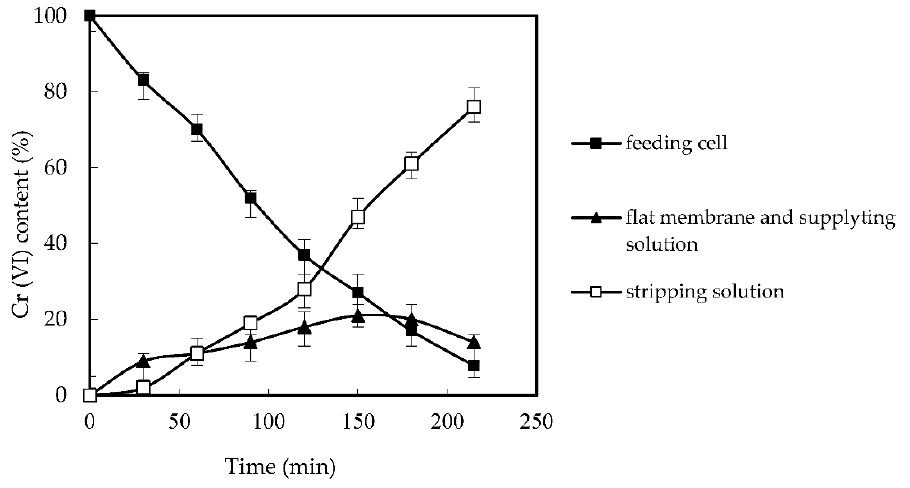
Figure 6. The retention of Cr (VI).